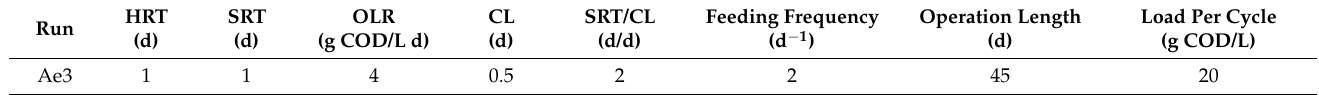
Table 3. Operating parameters applied to Ae3